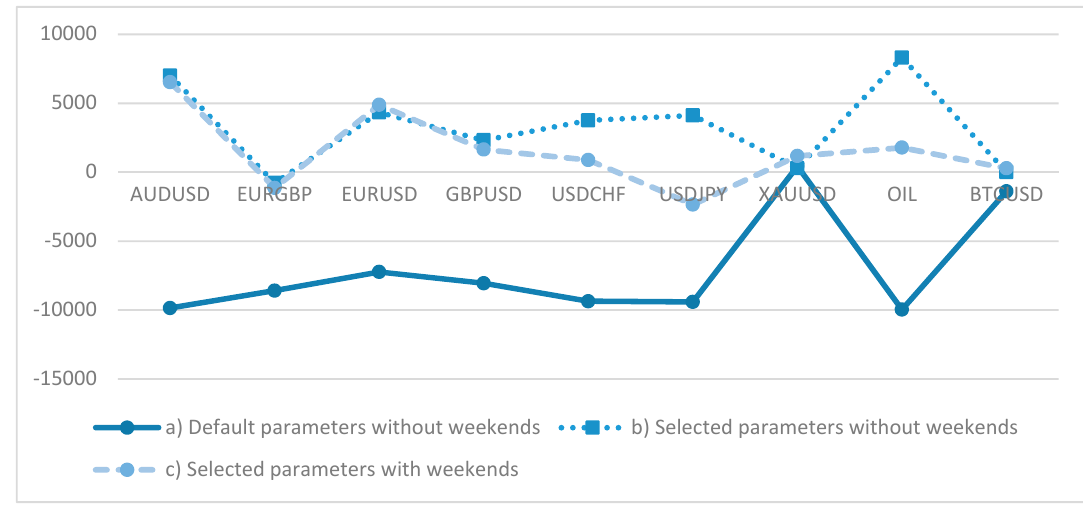
Figure 6. Net Profits of experiments (a), (b), and (c).